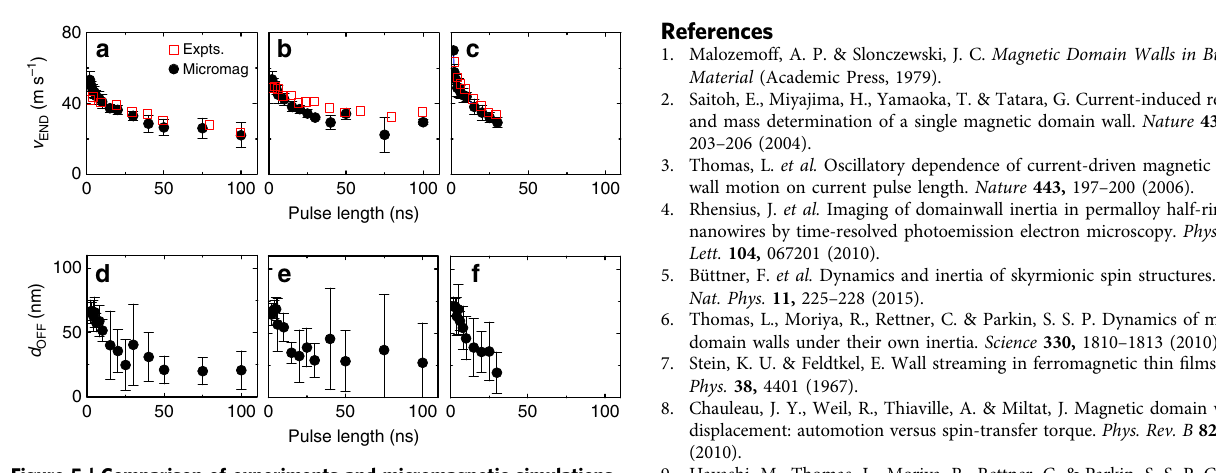
Supplementary Table 1. Wires, B 5 m m or B 50 m m wide and B 30 m m to B 40 m m long, are patterned using optical lithography and Ar ion etching. A subsequent lift-off process is used to form electrical contacts made of 5nm Ta|100nm Au.